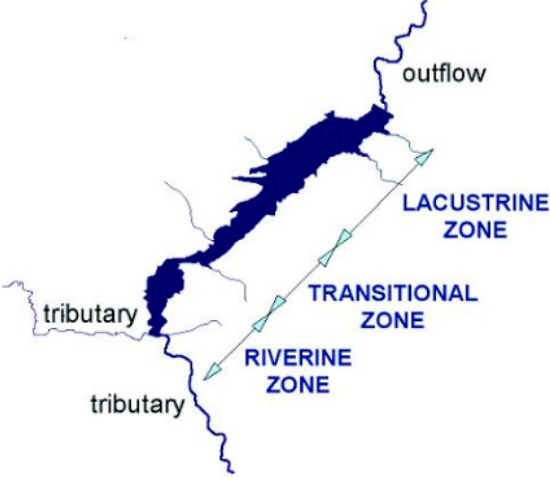
Figure 2. Division of the Sulejów Reservoir into riverine, transitional and lacustrine zone [24]. Table 1. Morphometric parameters of the Sulejów Reservoir.